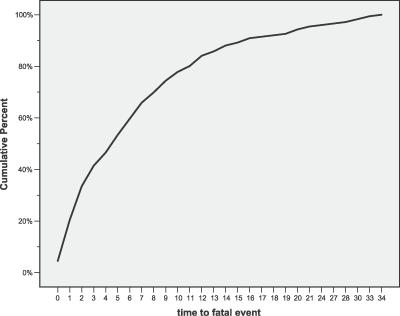
Timing of In-Hospital DeathDay 14 represents the percentage of all deaths (176) that occurred in the second week (day 14 to 20), and day 21 represents the percentage of all deaths that occurred on or after 21 d of inpatient treatment.